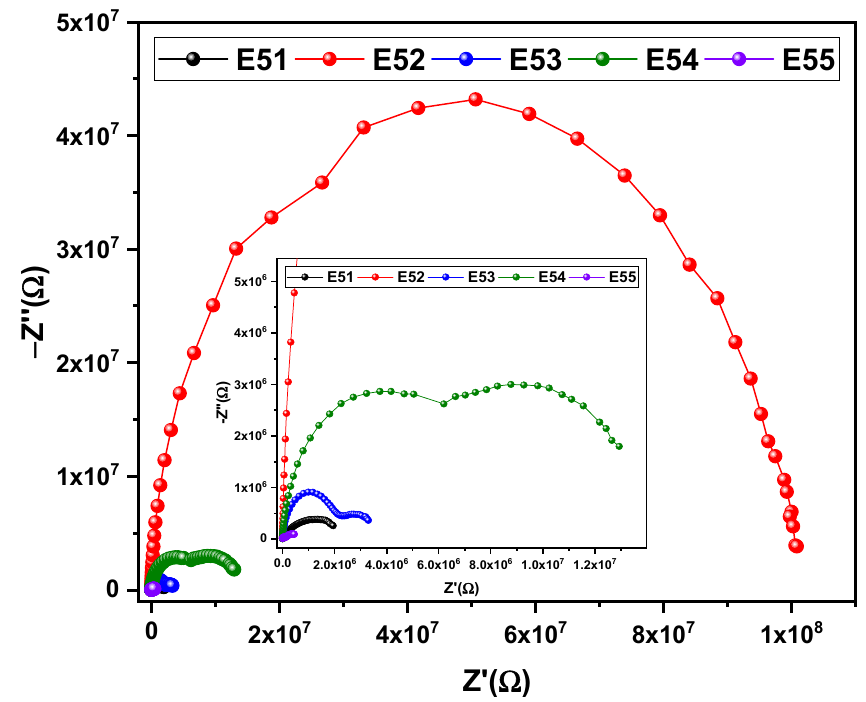
Figure 5. Obtained Nyquist plots for the nano-ZnO-incorporated coatings after 1 h of exposure.